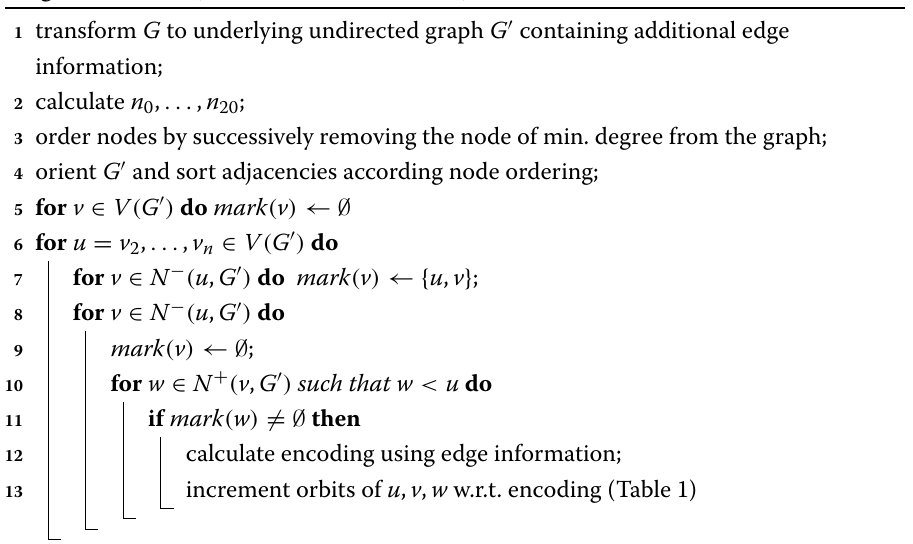
Algorithm 2: K3 (Chiba and Nishizeki